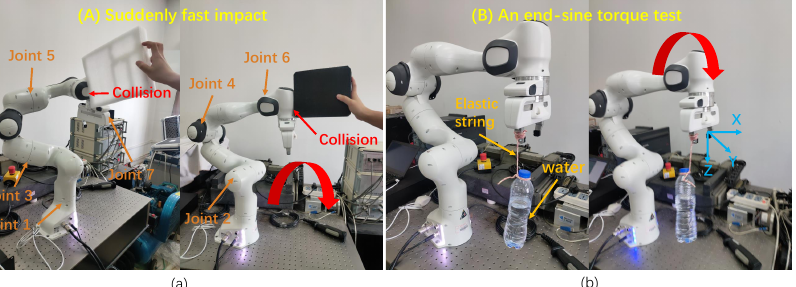
Figure 10. Dynamic external torque detection experiment: ( a ) Suddenly fast impact; ( b ) An end-sine torque